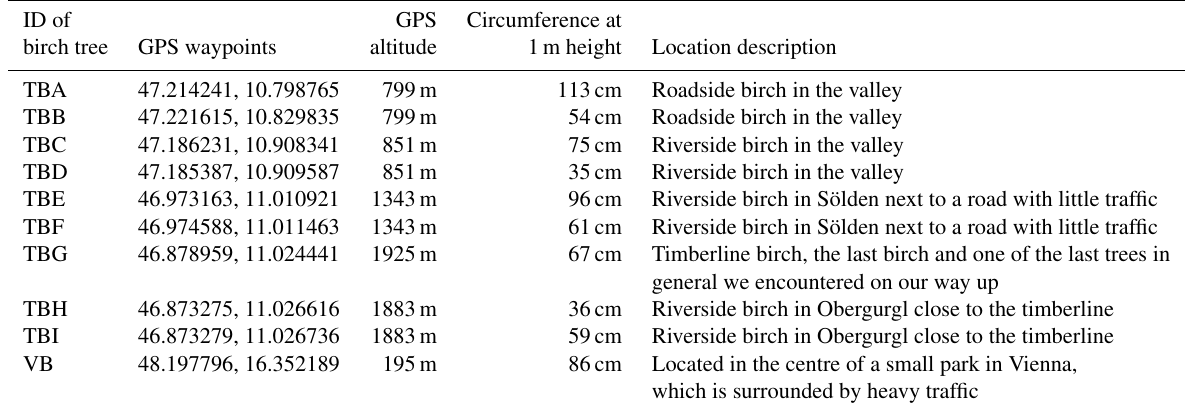
Table 1. Further information on the sampled birches, with sample name, GPS waypoints, altitude of the growing site, circumference, and description of the growing